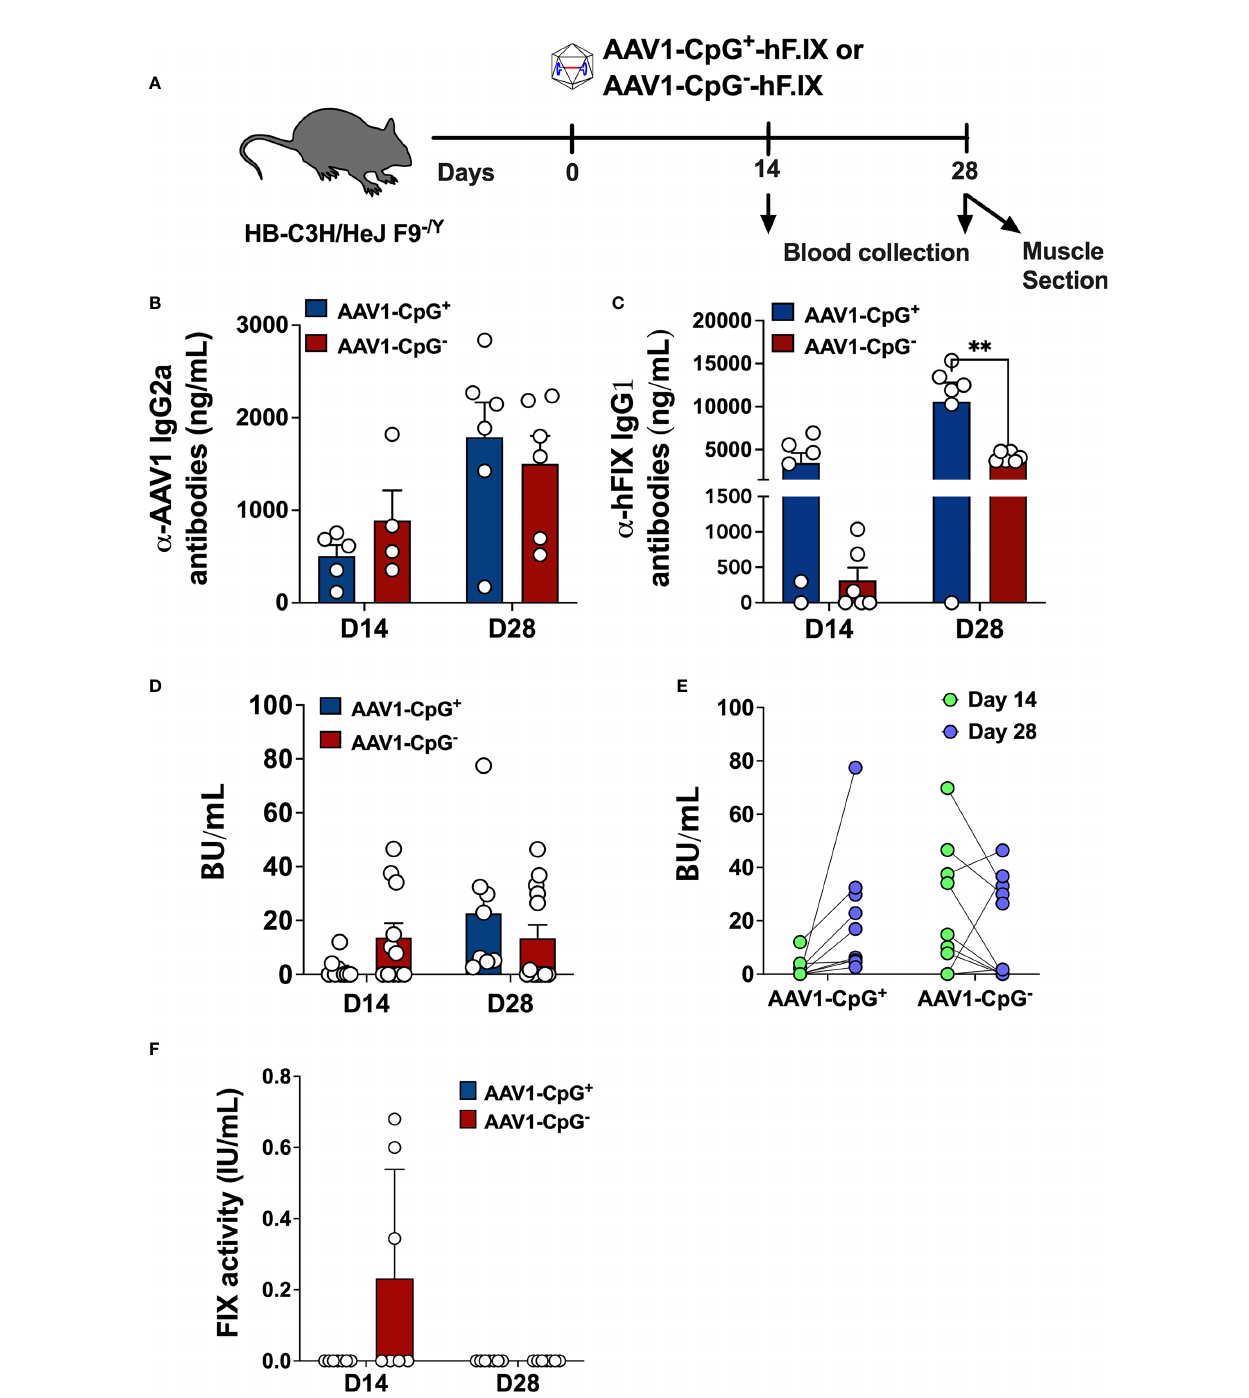
FIGURE 3 | CpG depletion has no effect on antibody formation against capsid but changes the dynamics of the anti-hFIX response in hemophilia B mice. (A) Experimental timeline of hemophilia B (C3H/HeJ F9 − /Y ) mice injected with AAV1-CpG + or AAV1-CpG − vector. (B) Anti-AAV1 IgG2a antibody titers in plasma samples of hemophilia B mice injected with AAV1-CpG + or AAV1-CpG − vector. Samples were collected at day 14 and 28 post vector injection. (C) anti-hFIX IgG1 antibody titers anti-AAV1 IgG2a antibody titers in plasma samples of hemophilia B mice injected with AAV1-CpG + or AAV1-CpG − vector. (D) Bethesda inhibitor titers (BU/ml) in plasma samples of hemophilia B mice injected with AAV1-CpG + or AAV1-CpG − vector. (E) Correlation between inhibitor titer at different time points within the same group. (F) Percent hFIX coagulation activity as assessed by Rossix ROX Factor IX chromogenic assay. Data are average ± SEM of at least four animals per group and is representative of two independent experiments. Each circle represents an individual animal. Statistically signi fi cant differences are indicated. **P <